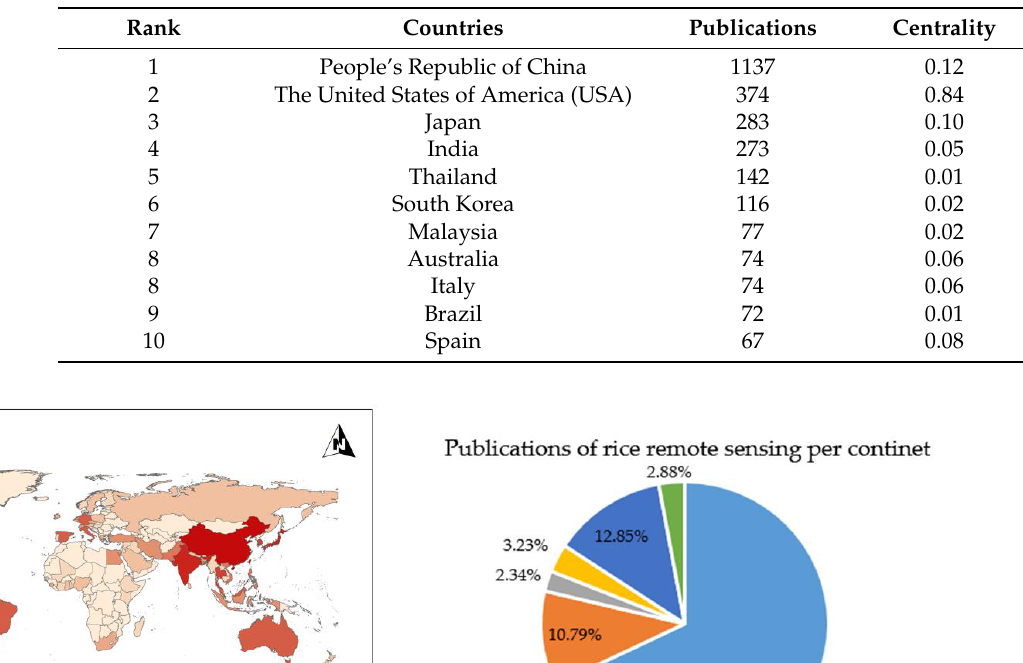
Table 2. Top 10 countries in the number of publications.